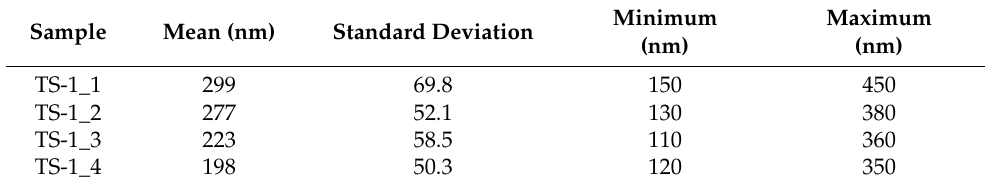
Figure 5. The particle-size distribution of TS-1 materials. Table 2. The statistical data concerning the particle size distribution. Table 2. The statistical data concerning the particle size distribution.